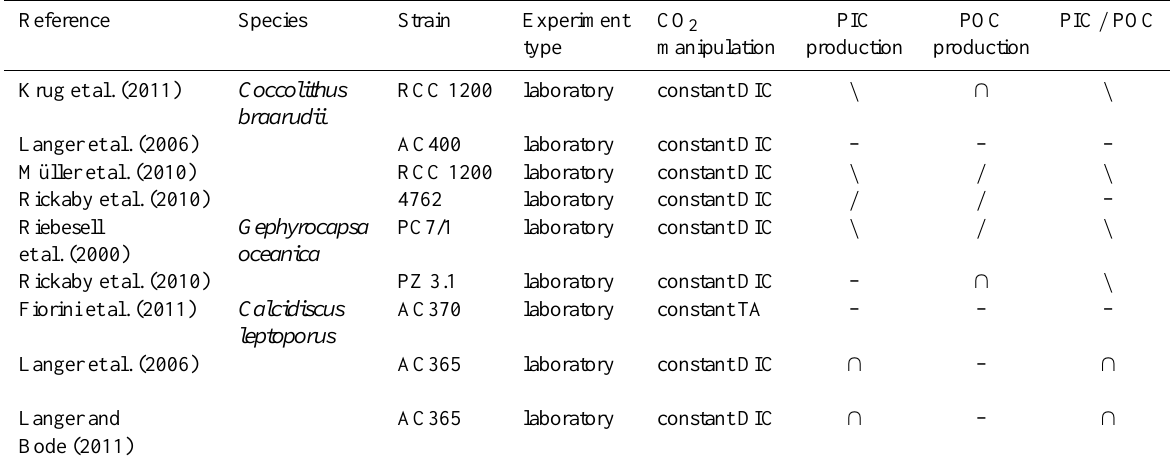
Table 2. Summary of the available carbonate chemistry manipulation experiments and the responses of Coccolithus braarudii , Gephyrocapsa oceanica and Calcidiscus leptoporus found in those